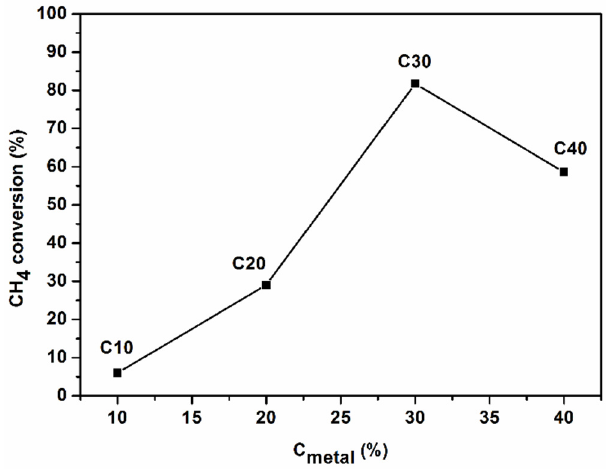
Figure 9. Methane conversion of the catalysts prepared with different metal ion contents during the POM for 10 h at 750 °C and a gas flow rate of 800 mL min − 1 .